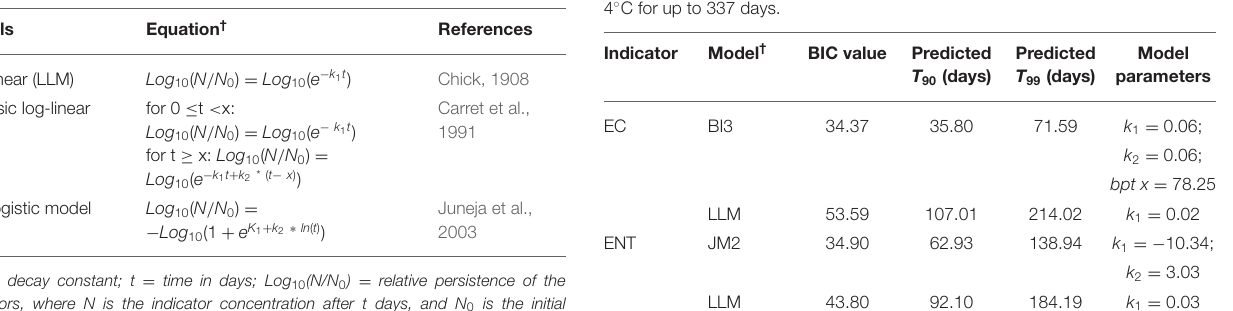
TABLE 2 | Descriptions and properties of the log-linear model and best-fit equations (biphasic log-linear, and log-logistic) that mathematically evaluated the relationship of enterococci 23S rDNA , and Escherichia coli uidA from microcosms containing sewage spike river water stored at 4 ◦ C for up to 337 days.